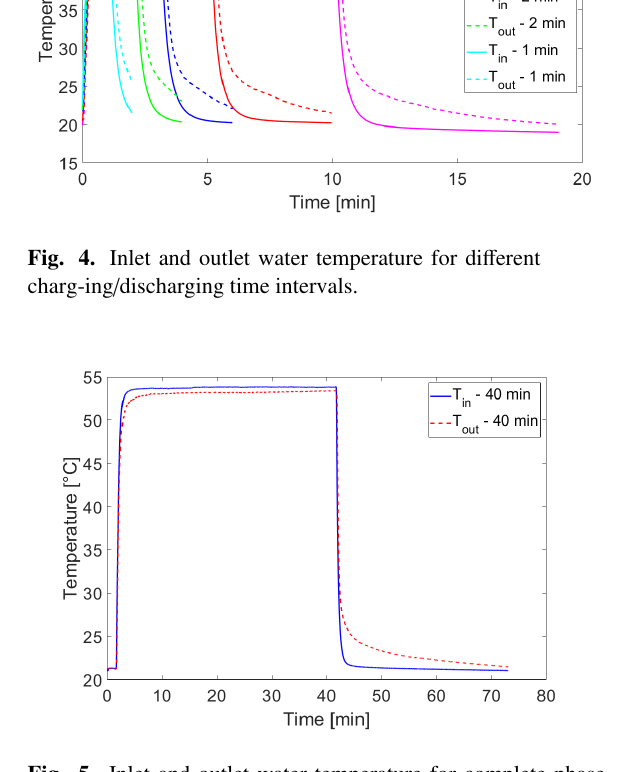
Fig. 5. Inlet and outlet water temperature for complete phase